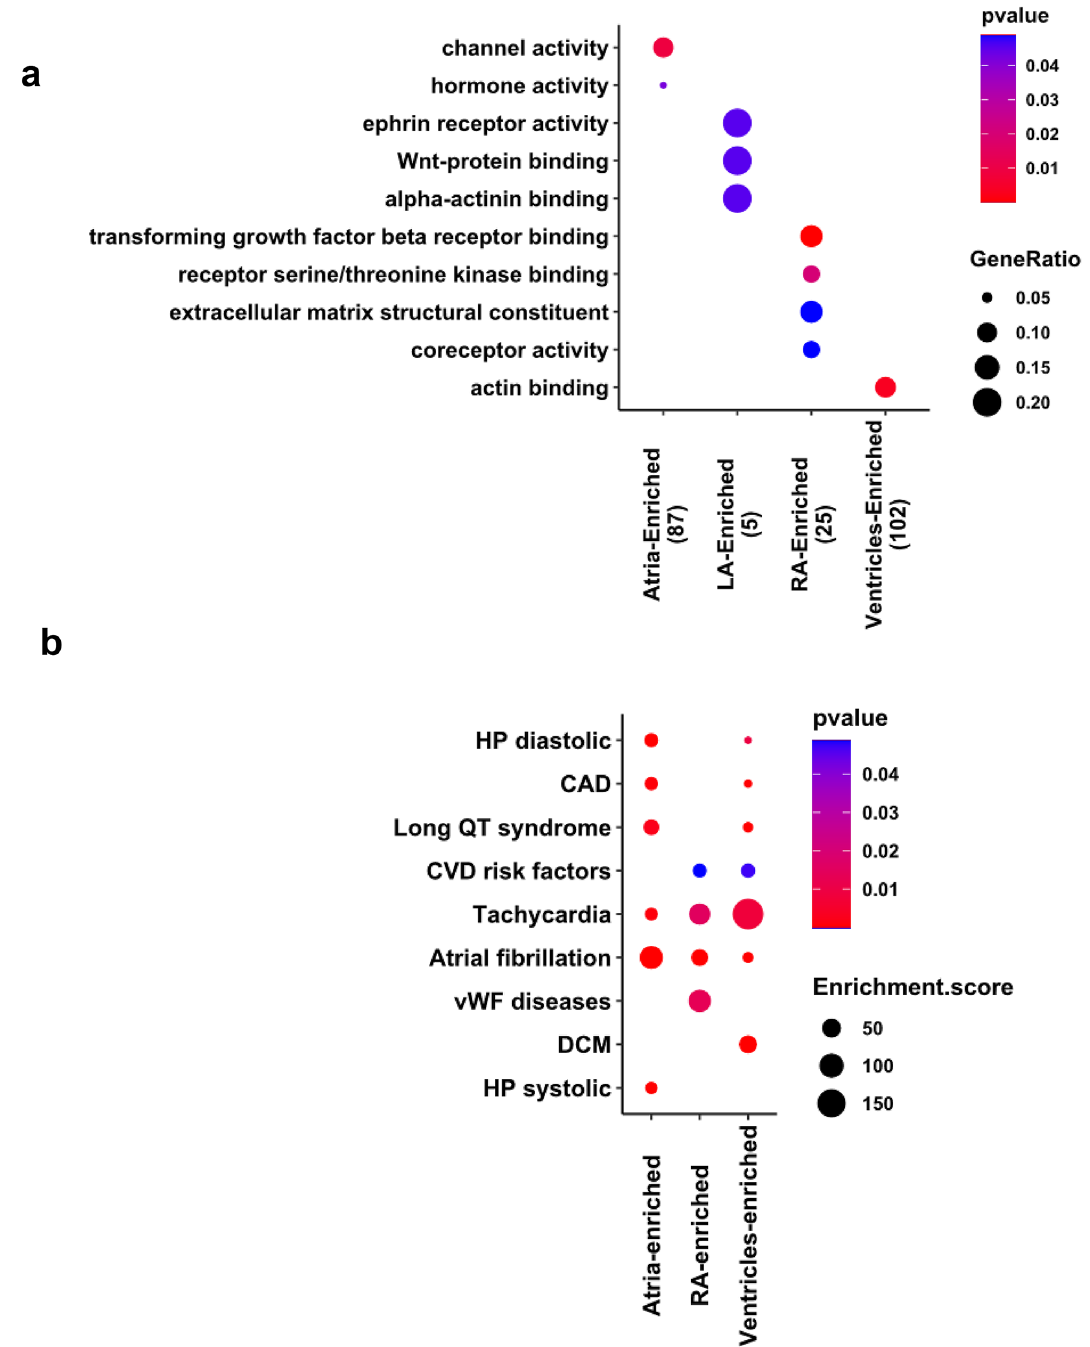
Figure 4. Non-failing human hearts demonstrated chamber enriched pathways and chamber specific genes associated with cardiovascular disorders. ( a ) Comparison of over-representative GO (Gene Ontology) pathways among Subregion-Enriched gene sets (sets with fewer than five genes are omitted). Gene Ontology pathways summarizing the top 10 significantly enriched terms (adjusted p value < 0.05) were shown. The size of the dot reflects the GeneRatio (Proportion of Subregion-Enriched genes that associated with the given GO) and the color of the dot indicates increasing significance of the enriched pathways from blue to red. Number of genes in the gene sets are in parentheses. ( b ) Significantly enriched GWAS archived cardiovascular diseases represented by heart abundant chamber specific genes. The size of the dot reflects the Enrichment score (the odds that the GWAS trait is over-represented among genes of interests vs. the odds among all other genes) and the color of the dot indicates increasing significance of the enriched GWAS trait from blue to red. Significantly enriched terms are presented and significance is indicated as p <